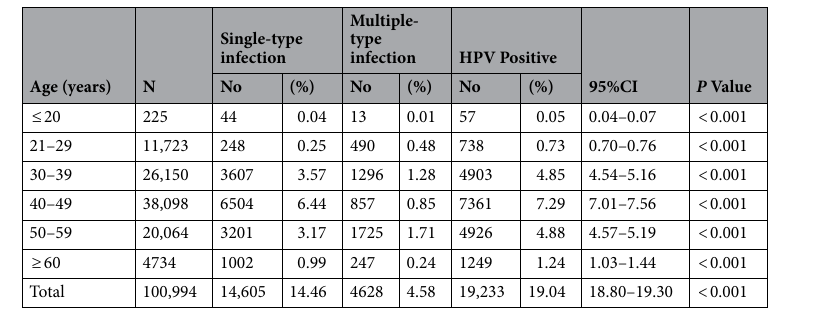
Table 2. Single and multiple type infections of HPV in different age